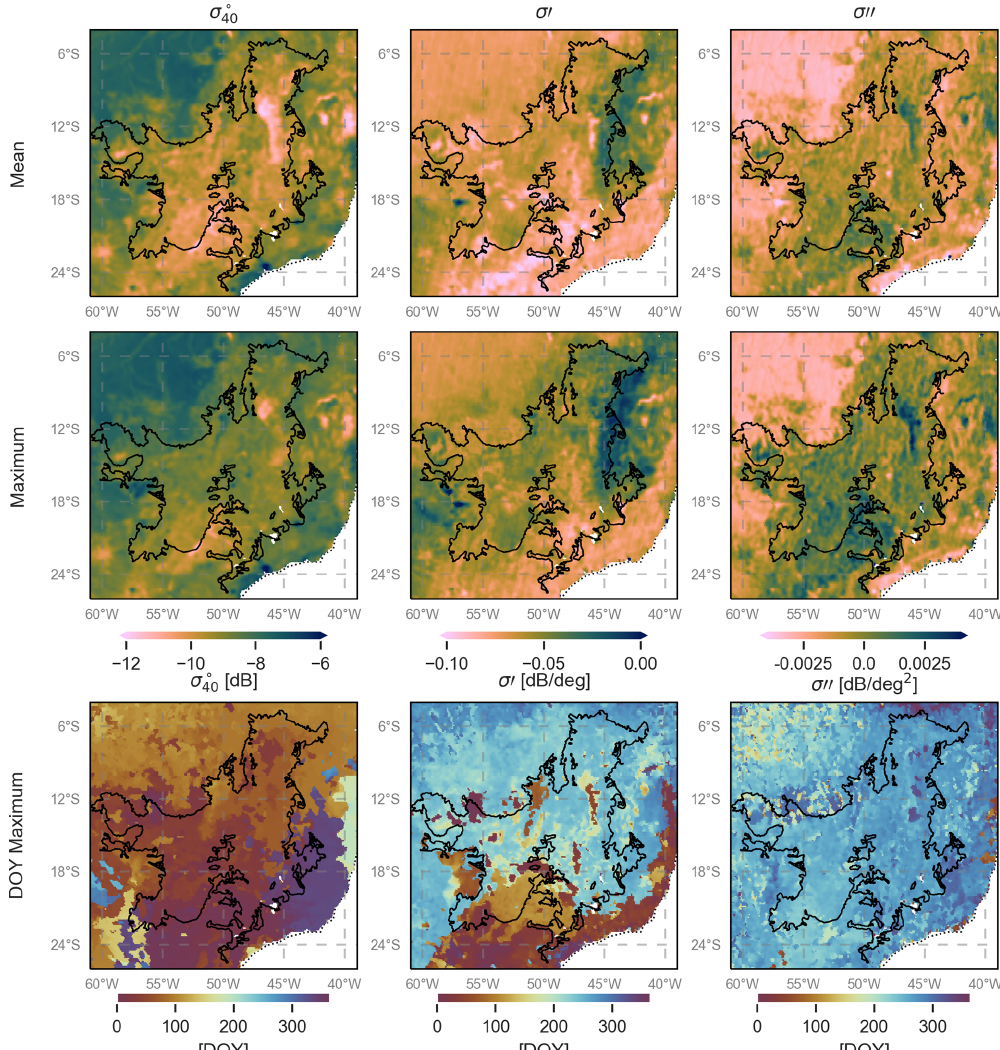
Figure 8. Mean, maximum, and DOY of maximum for backscatter, slope, and curvature over the